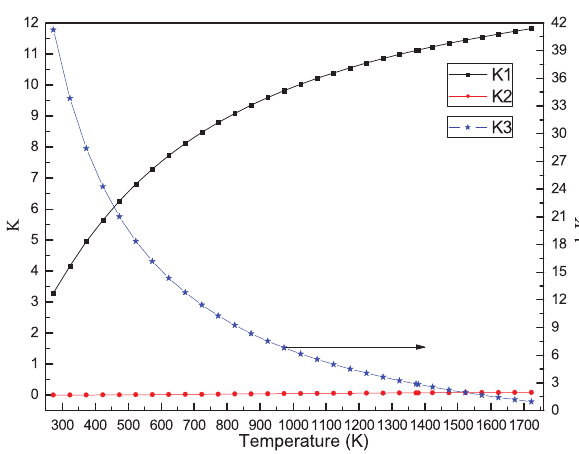
Fig. 2: The curves of K − T for reactions